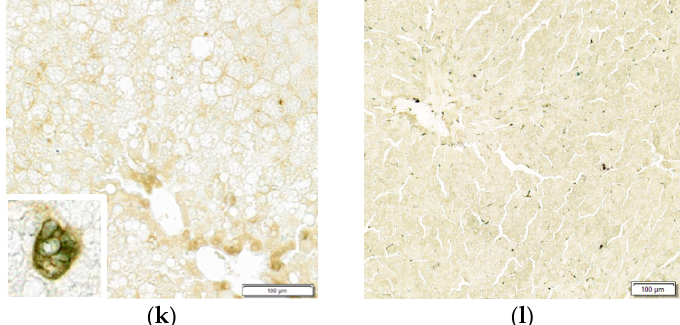
Figure 3. Histopathology of the liver in ( a ) cont; ( b ) high ‐ fat (HF); ( c ) high ‐ fat and high iron (HFHI) and ( d ) high ‐ iron (HI) groups at week 30. Hematoxylin and eosin (HE) stain, bar: 50 μ m. In HF and HFHI groups, ( e ) microgranuloma (surrounded by arrowheads) and ( f ) large inflammatory foci are seen in the hepatic parenchyma. HE stain, bar: 20 μ m. The number of ( g ) microgranulomas and ( h ) inflammatory foci per 20× field were counted ( n = 4 or 3 in each group). * p < 0.05 vs. control, † vs. HF, ‡ vs. HFHI, by Tukey–Kramer’s multiple comparison. Iron staining of the liver in ( i ) cont; ( j ) HF; ( k ) HFHI and ( l ) HI groups. DAB ‐ enhanced Perls stain, bar: 100 μ m. Inset in ( k ) indicates a microgranuloma with intense iron staining.